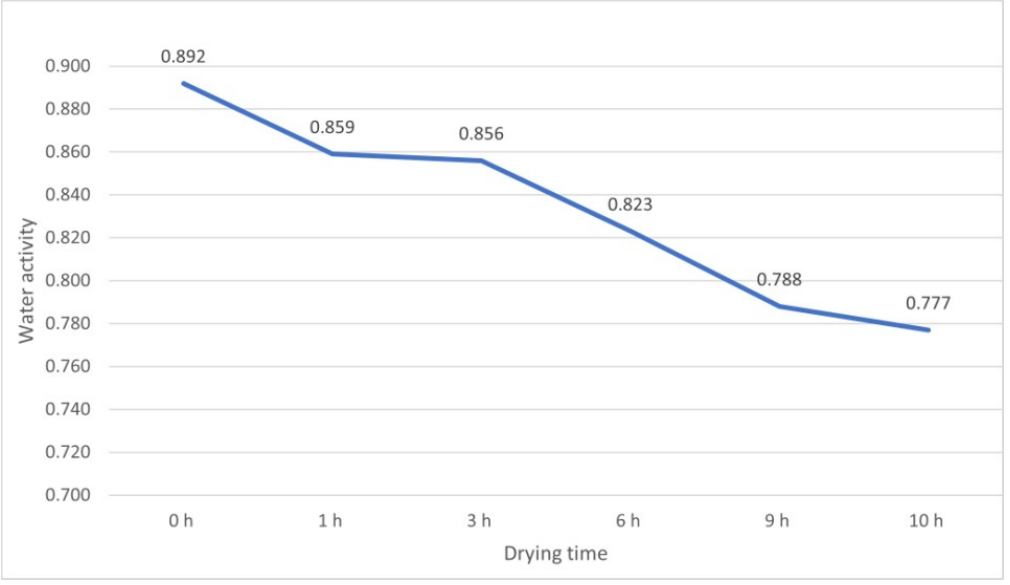
Figure 21. Drying curve—mean Wa in the chamber 4.